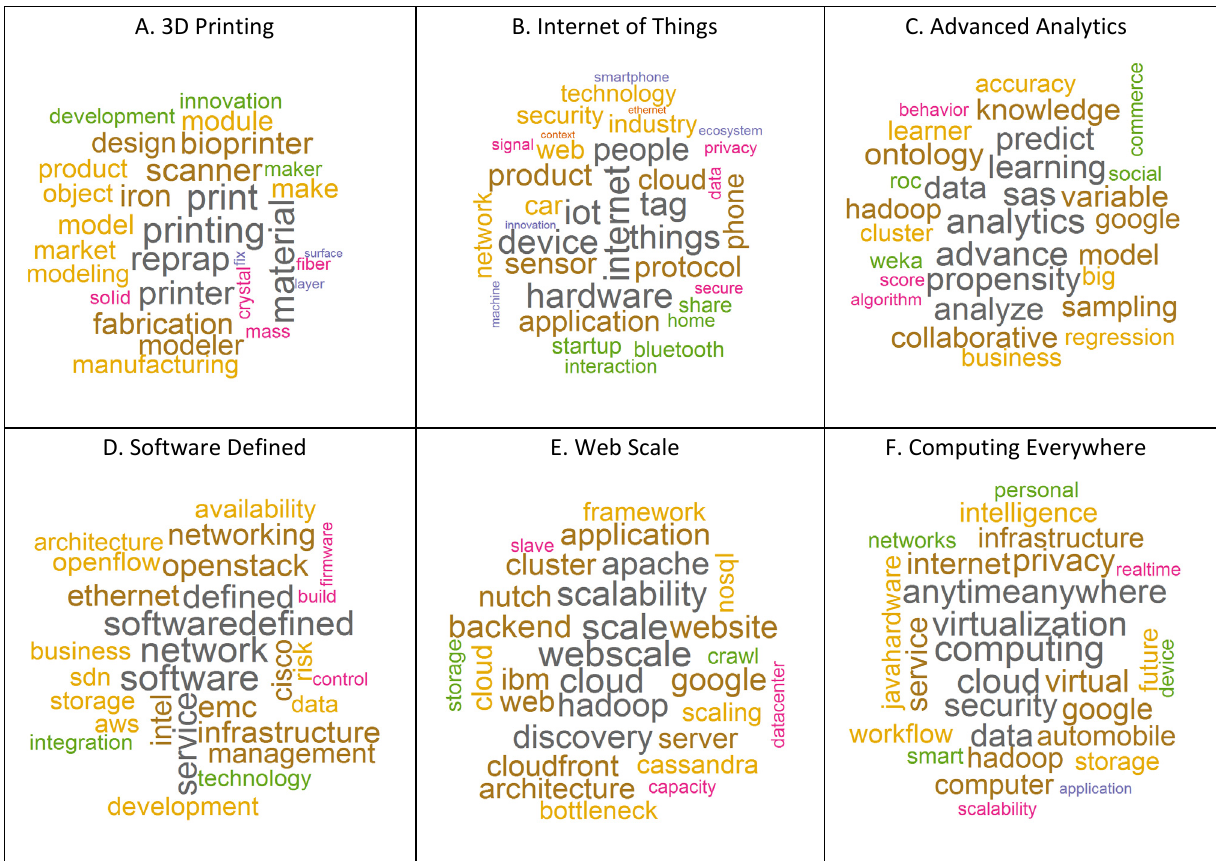
Fig. 3. The word cloud in each category extracted from CBDIR (A: 3D Printing, B: Internet of Things, C: Advanced Analytics, D: Software Defined, E: Web Scale, F: Computing